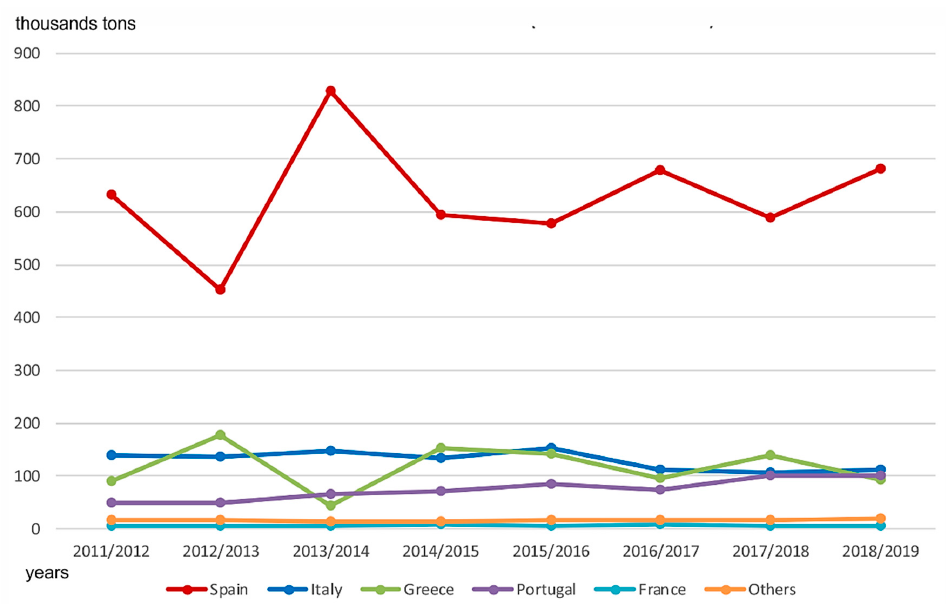
Figure 11. Total exports volume. Compiled by the authors based on [81].